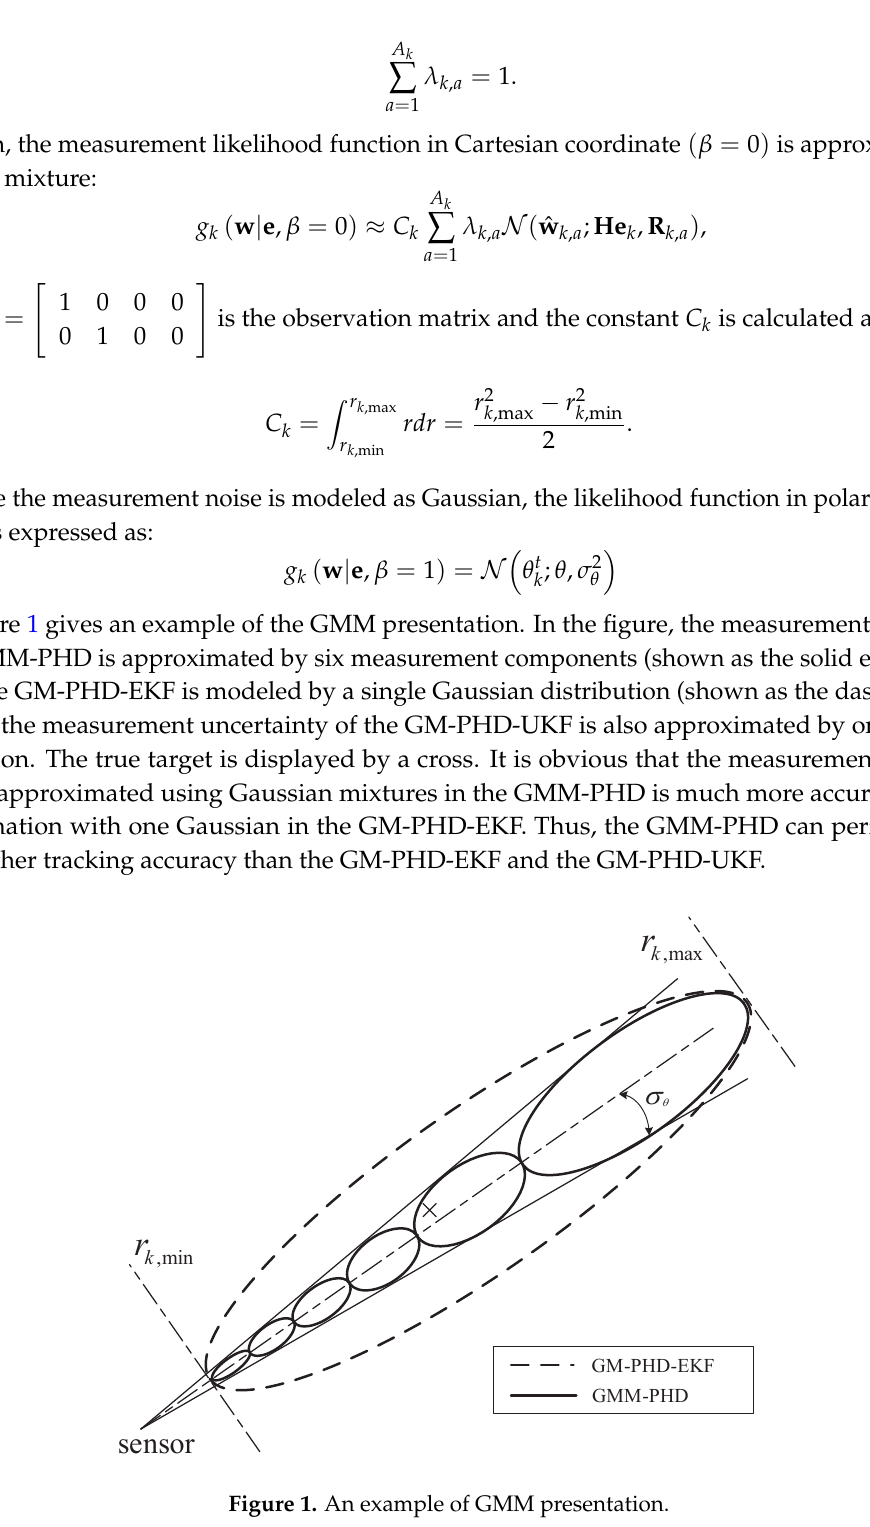
Figure 1. An example of GMM